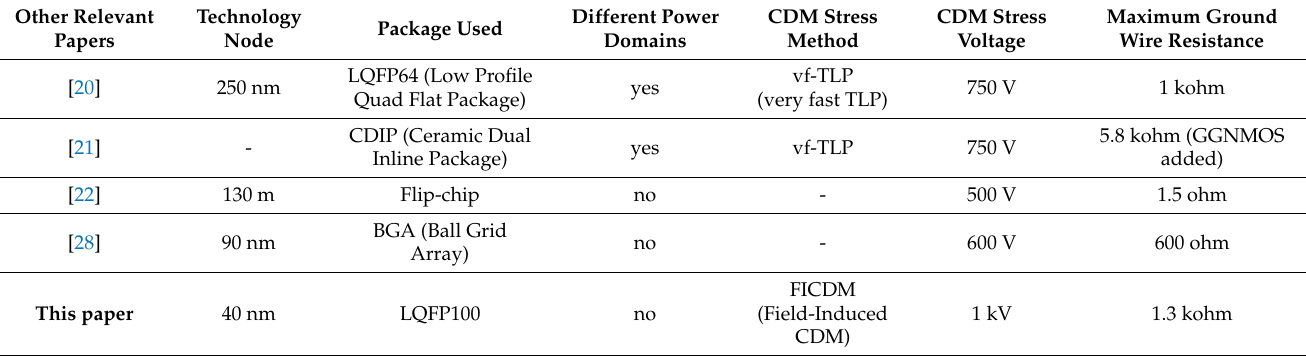
Table 3. Performance analysis with similar